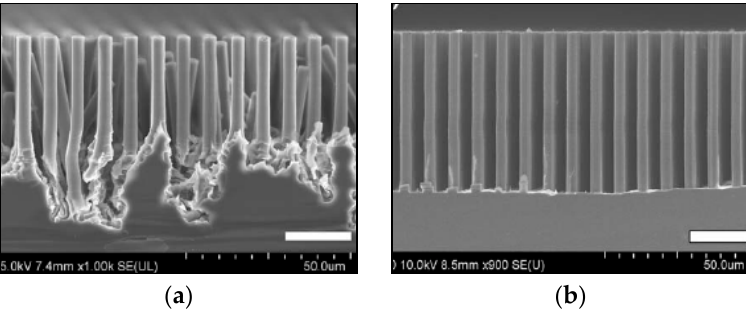
Figure 9. Cross-sectional SEM images of the as-etched Si produced with a catalyst of 40/5 nm thick Au/Ti of n-type Si (100) substrate (0.9–1.1 Ω cm). The etching temperatures are 30 °C ( a ) and 8 °C ( b ), respectively. The etching duration and concentration of H 2 O 2 are 12 h and 0.2 M, respectively. Scale